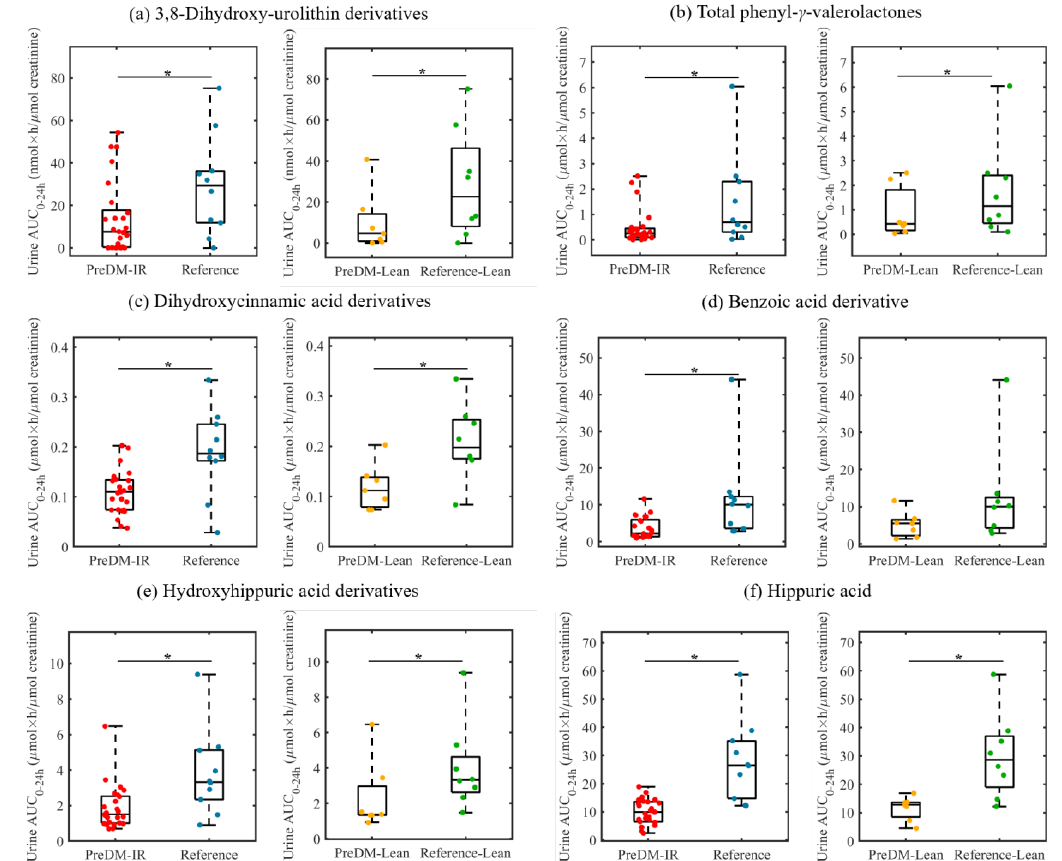
Figure 6. Box plots showing AUC 0–24 h (areas under the 24 h curve) of microbial (poly)phenolic metabolites in urine post-consumption of the RRBtest drink in PreDM-IR (red dots) vs. Reference (blue dots) and PreDM-Lean (yellow dots) vs. Reference-Lean (green dots): ( a ) 3,8-dihydroxy-urolithin derivatives; ( b ) total phenyl- γ -valerolactones; ( c ) dihydroxycinnamic acids derivatives; ( d ) benzoic acids derivatives; ( e ) hydroxyhippuric acids derivatives; ( f ) hippuric acid. * Significantly different, p < 0.05.